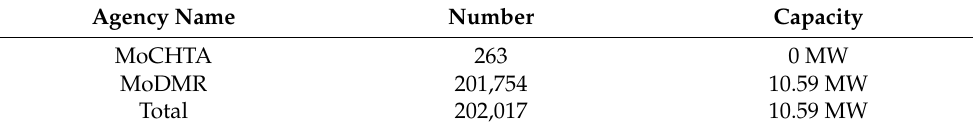
Table 8. Statistics of installed solar street lights (authors’ creation based on SREDA data [21]).